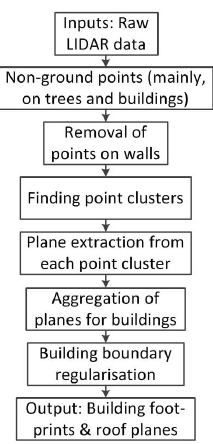
Figure 2: The proposed building extraction method.